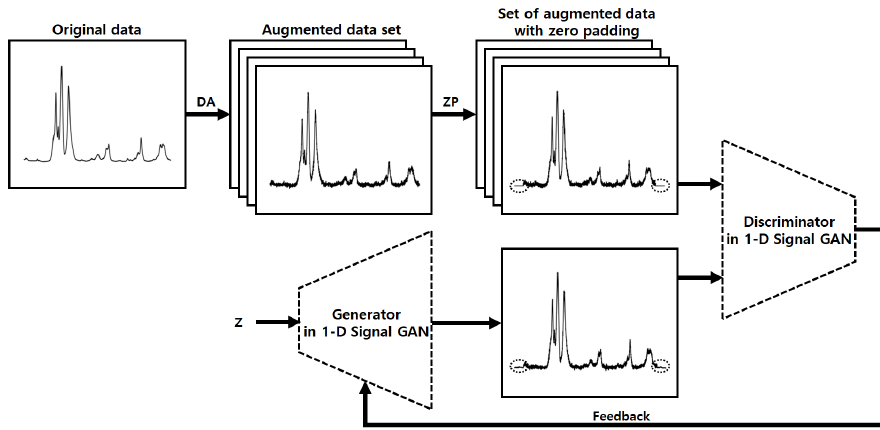
Figure 2. The first training process in the proposed system.